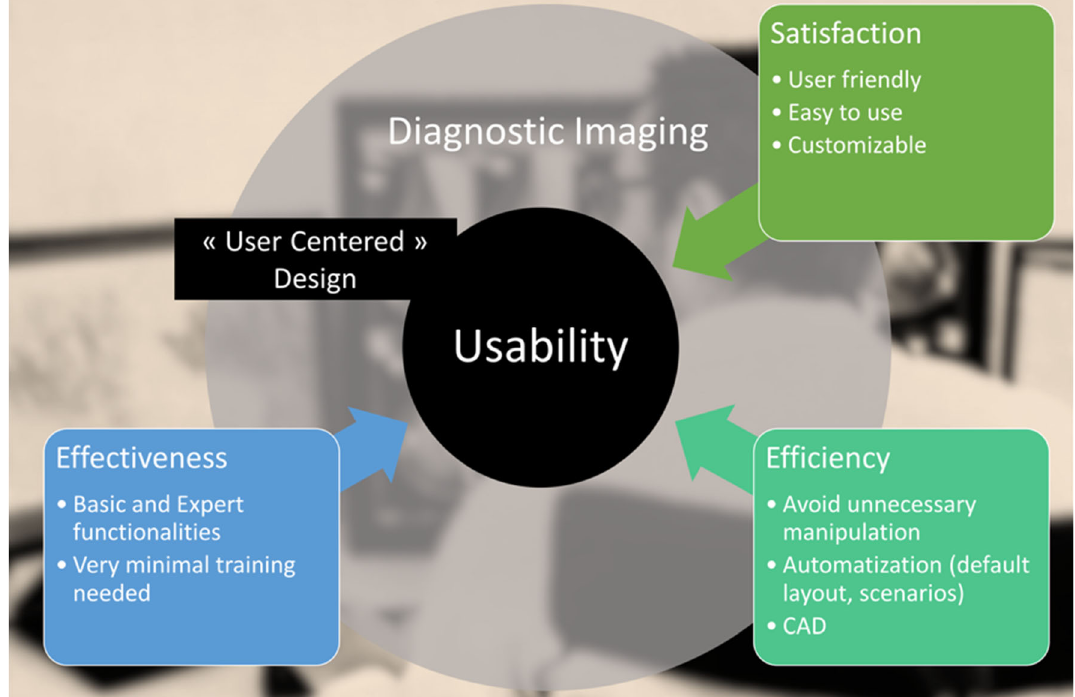
Fig. 12 User-centred design for diagnostic imaging viewer. To maximize usability, the design of the interface needs to integrate the user and environmental requirements and constraints. Automatization and CAD have to facilitate use in order to minimize time and effort for image